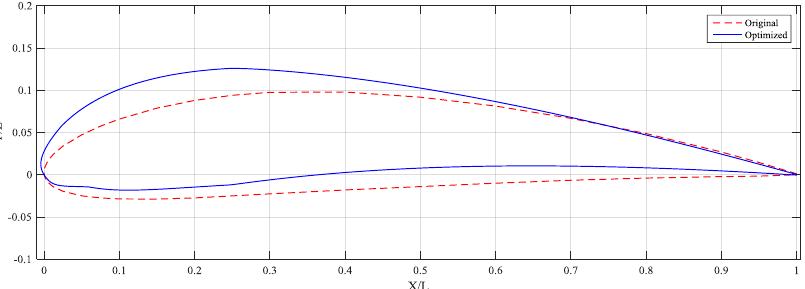
Figure 7. Geometry comparison: NACA4412 airfoil and optimal airfoil.